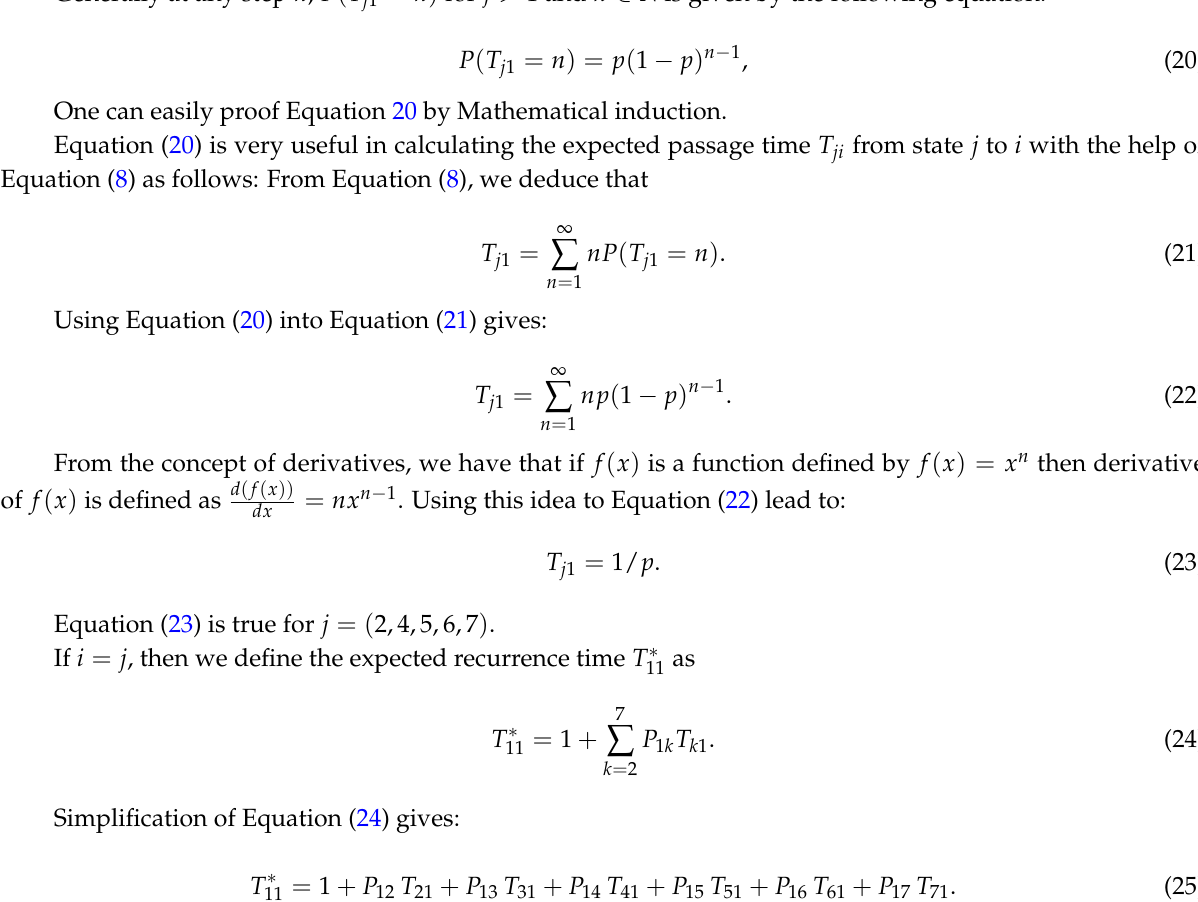
Figure 3. Hexagonal tiling in small complex to show the movement of the particle from state 2 to 1 at step one. Generally at any step n , P ( T j 1 = n ) for j > 1 and n ∈ N is given by the following